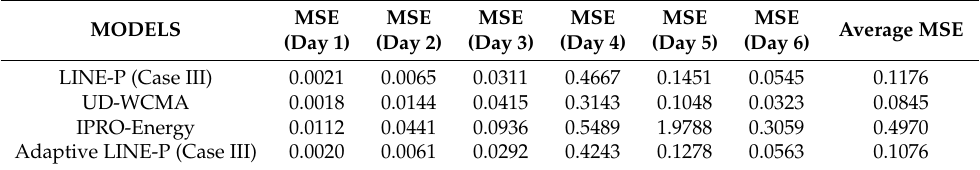
Table 15. Error comparison of the energy prediction models in terms of MAE for the wind energy